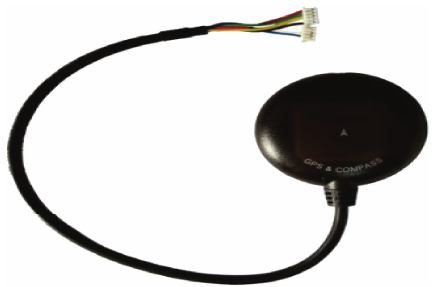
Figure 6: The appearance of GPS module.